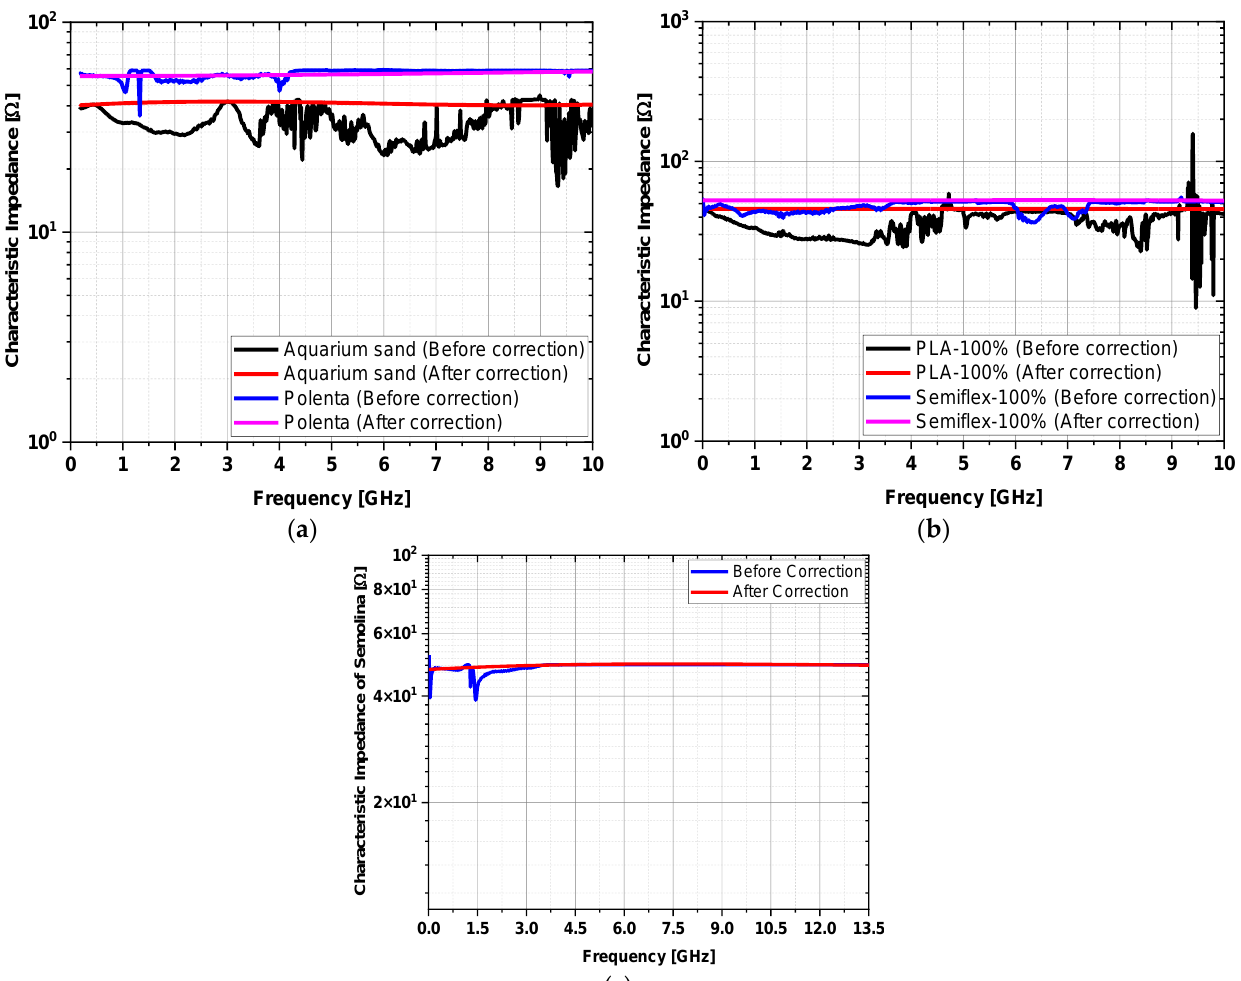
Figure 4. ( a ) Characteristic impedance of the circular coaxial fixture without the material under test (MUT); ( b ) characteristic impedance of the rectangular coaxial fixture without the material under test (MUT).